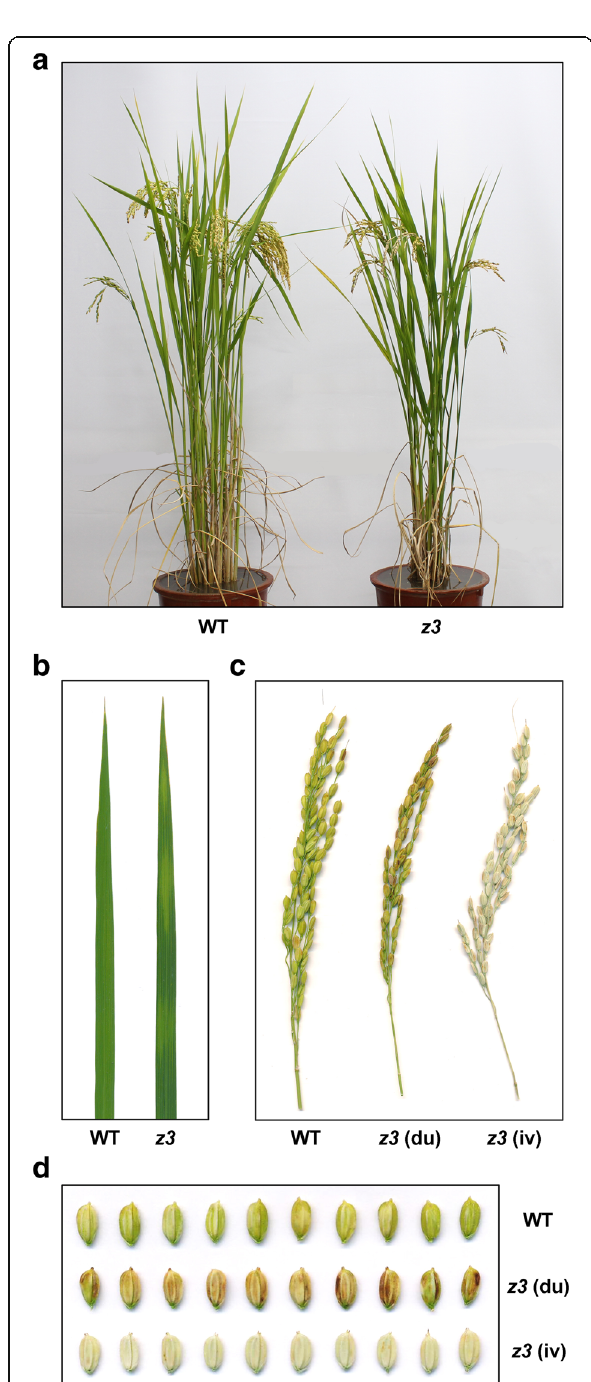
Fig. 1 Phenotypic characterization of the z3 mutant. a Phenotypes of the wild-type (WT) and z3 mutant plants at 140 days after sowing (DAS) grown under natural long day conditions in the paddy field. b Leaf phenotypes of the 140-day-old WT and z3 mutant plants grown in the paddy field. c – d Panicle ( c ) and grain ( d ) phenotypes of the WT and z3 mutant plants at 140 DAS grown under natural long day conditions. WT, wild type; z3 , zebra3 ; z3 (du), dull-brown colored grain of the z3 mutant; z3 (iv), ivory colored grain of the z3